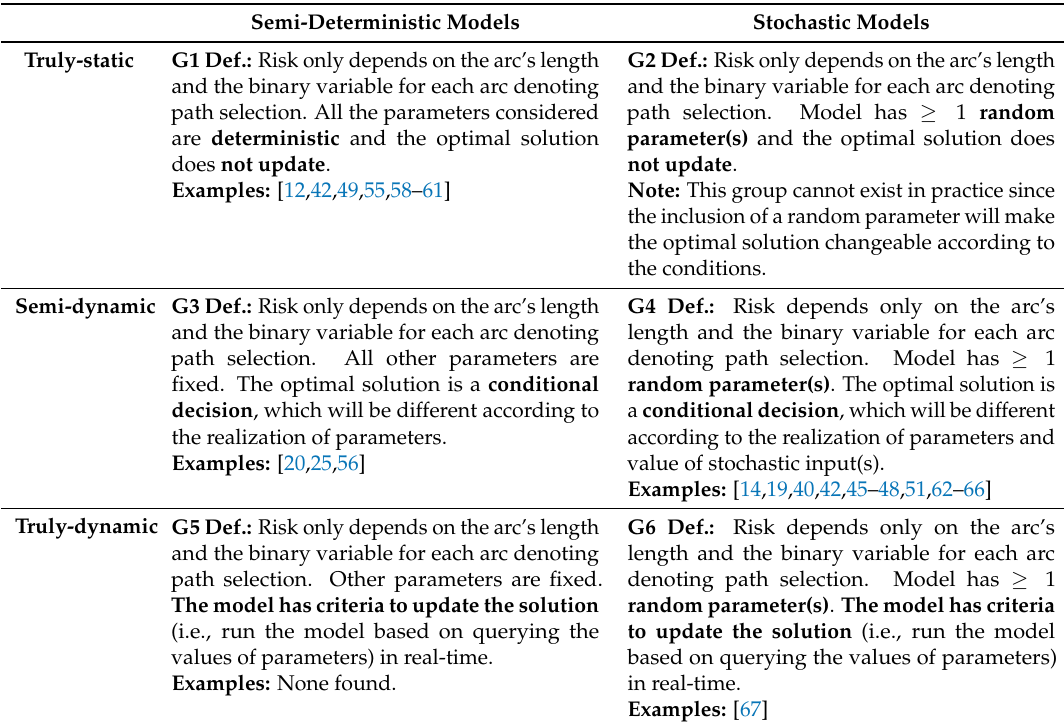
Table 2. An updated taxonomy of (hazmat) trucking optimization methods that consider crash